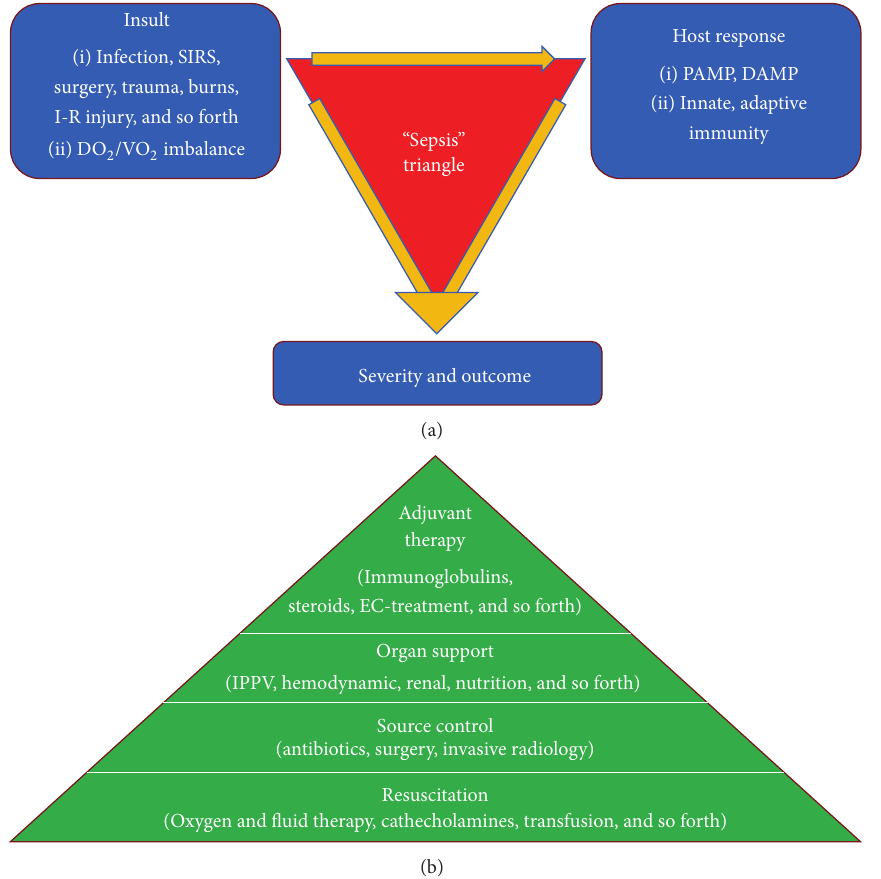
Figure 1: The “sepsis-triangles”: pathomechanism and treatment. SIRS: systemic inflammatory response syndrome, I-R: ischemia- reperfusion, DO 2 : oxygen delivery, VO 2 : oxygen consumption, PAMP: pathogen-associated molecular patterns, DAMP: damage-associated molecular patterns, EC: extra corporeal, and IPPV: intermittent positive pressure